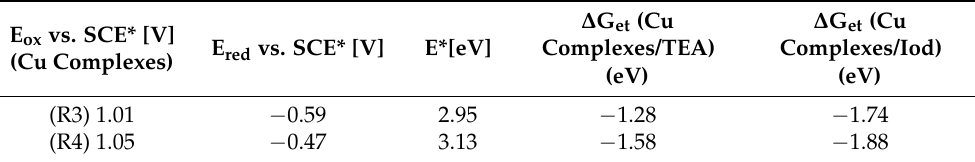
Table 2. Excited state energies E*, oxidation potentials E ox , and free energy change ( ∆ G et ) for the Cu complexes/amine/Iod interaction.